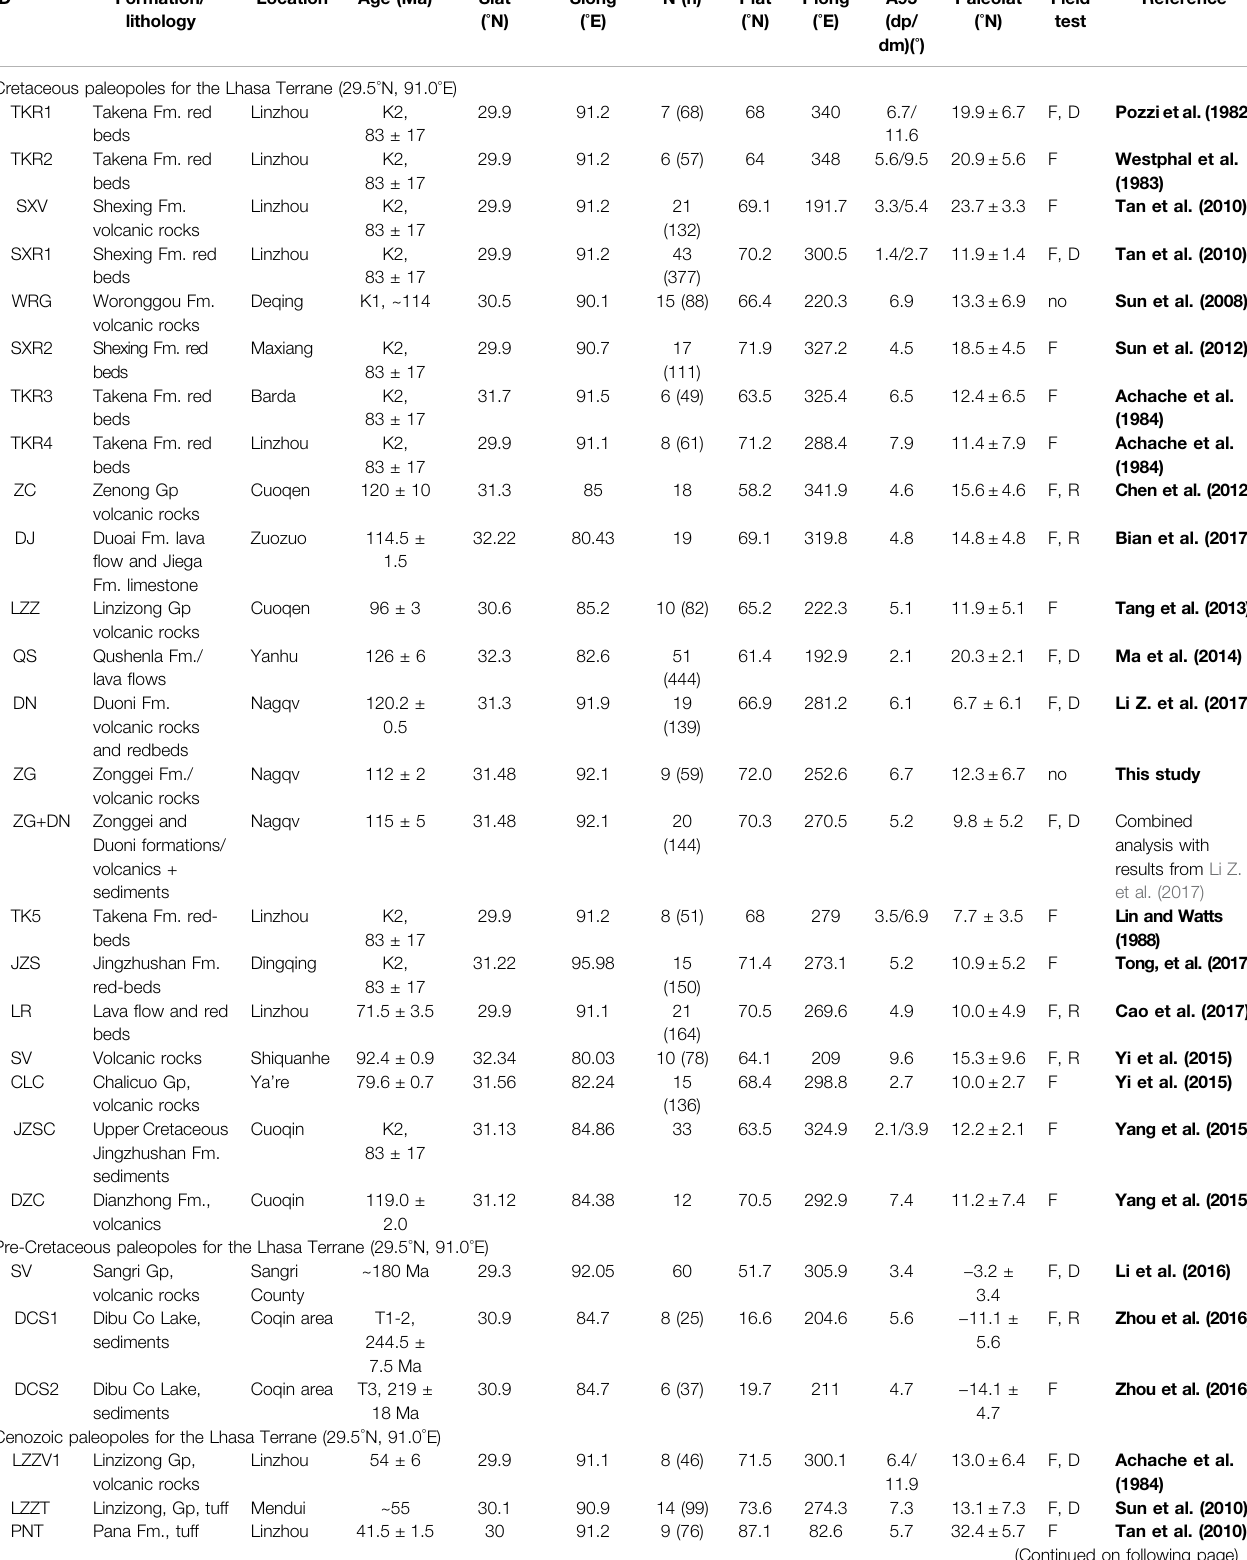
TABLE 2 | Summary of Cretaceous and Early Cenozoic paleomagnetic poles from the Lhasa and Tethyan-Himalayan (two are from interior of Indian craton) terranes. ID Formation/ lithology